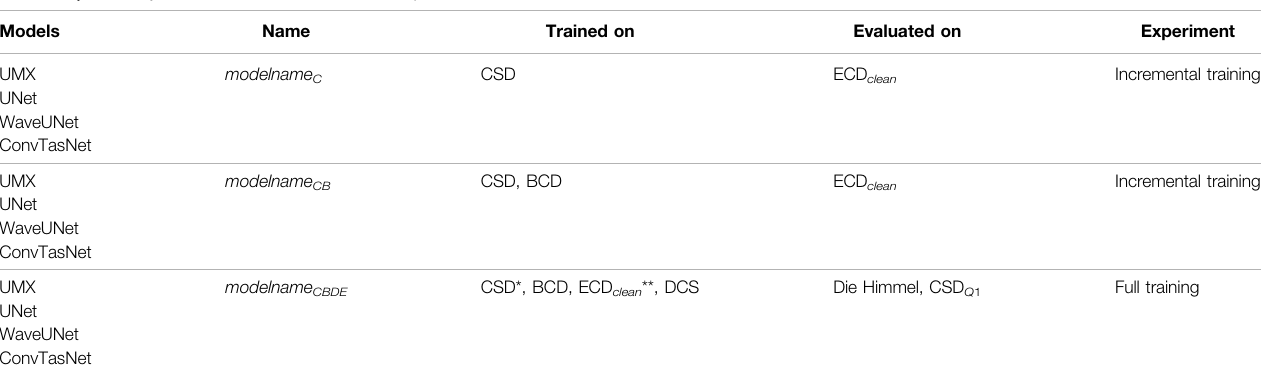
TABLE 3 | Summary of the models trained for each experiment.